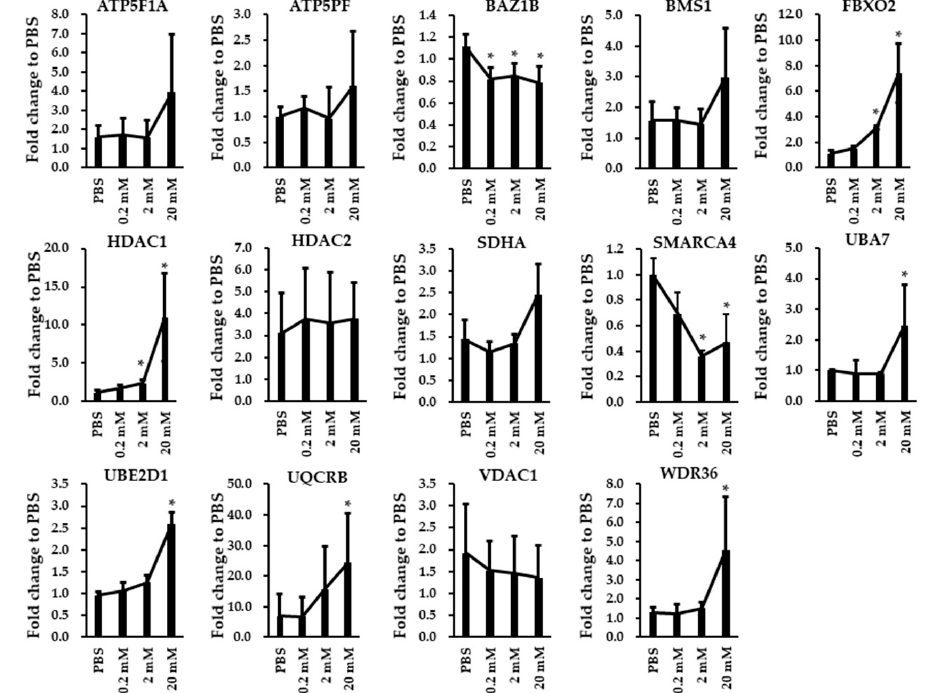
Figure 5. RT-qPCR assay showing the expression of 14 genes ( ATP5F1A , ATP5PF , BAZ1B , BMS1 , FBXO2 , HDAC1 , HDAC2 , SDHA , SMARCA4 , UBA7 , UBE2D1 , UQCRB , VDAC1 , and WDR36 ) in